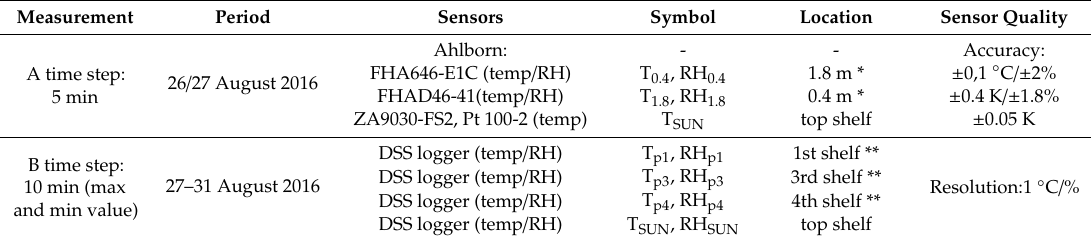
Table 1. Measurements in the first realization of green structure ( The Infinite Green ) in Wrocław, Poland. Measurement Period Sensors Symbol Location Sensor